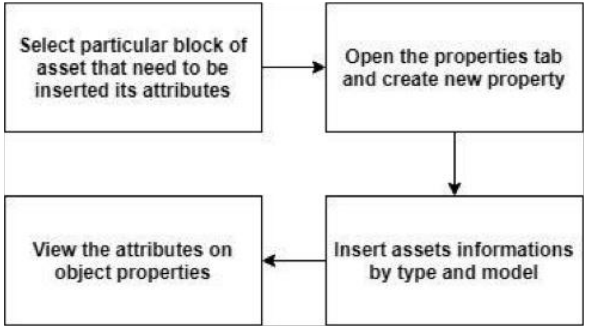
Figure 8: Attributes registration